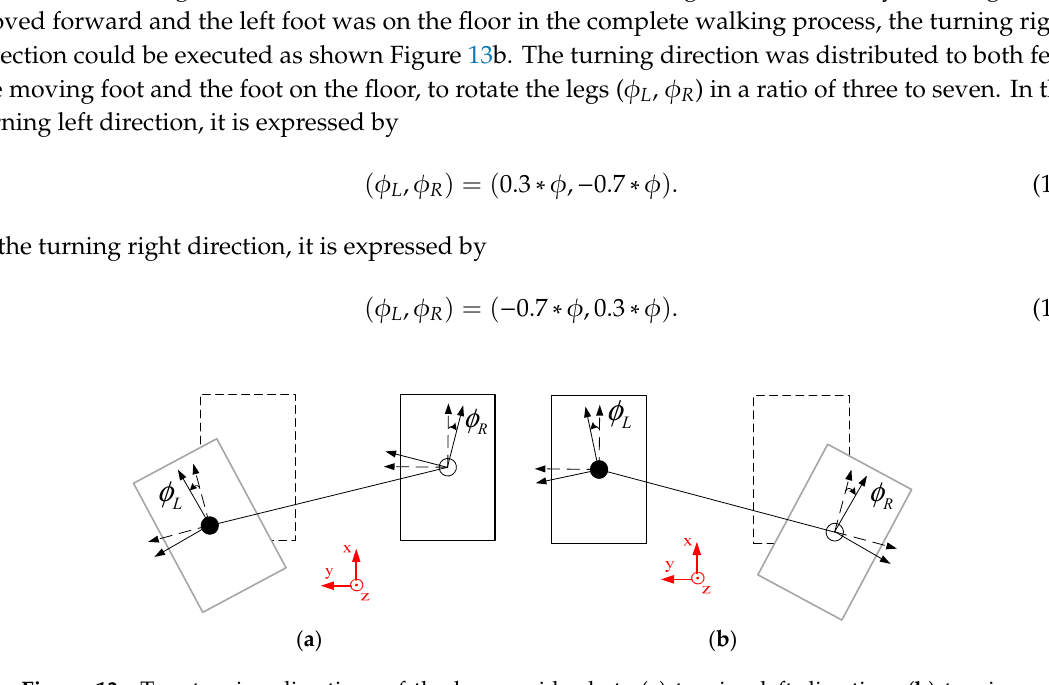
Figure 13. Two turning directions of the humanoid robot: ( a ) turning left direction; ( b ) turning right direction.